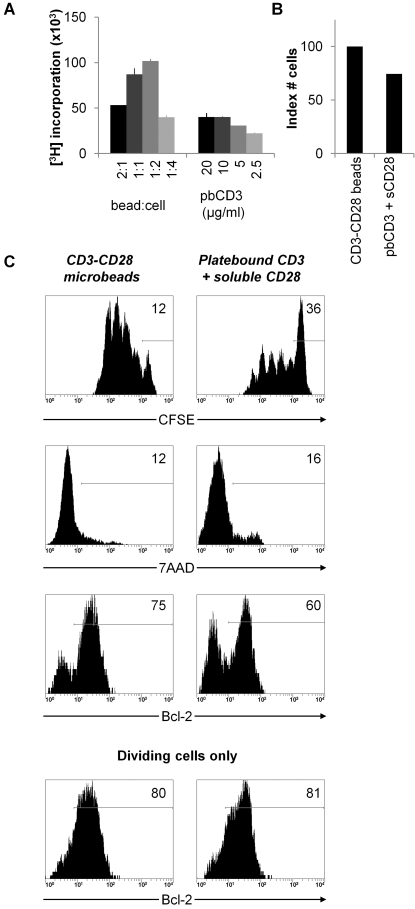
Determination of optimal mode and strength of primary polyclonal Treg stimulation.(A) Treg were stimulated with indicated ratios of anti-CD3+ anti-CD28 microbeads or with indicated concentrations of platebound anti-CD3+ soluble anti-CD28 (1 μg/ml) in the presence of IL-2 and IL-15. Proliferation was determined by measurement of [3H]Thymidine incorporation at day 4. (B) Indexed cell yield after primary polyclonal Treg culture using optimal strength of anti-CD3+ anti-CD28 microbeads (set to 100%) or platebound anti-CD3 plus soluble anti-CD28 stimulation. (C) Cell division pattern and survival/death signals of Treg after different primary polyclonal stimulations. Treg were stained with CFSE and stimulated with optimal strength of anti-CD3+ anti-CD28 microbeads or platebound anti-CD3+ soluble anti-CD28. CFSE dilution pattern, 7AAD staining and Bcl-2 expression of Treg population were assessed at day 4. In the lowest row, Bcl-2 expression is depicted gated on dividing Treg only. Data are representative of four independent experiments.